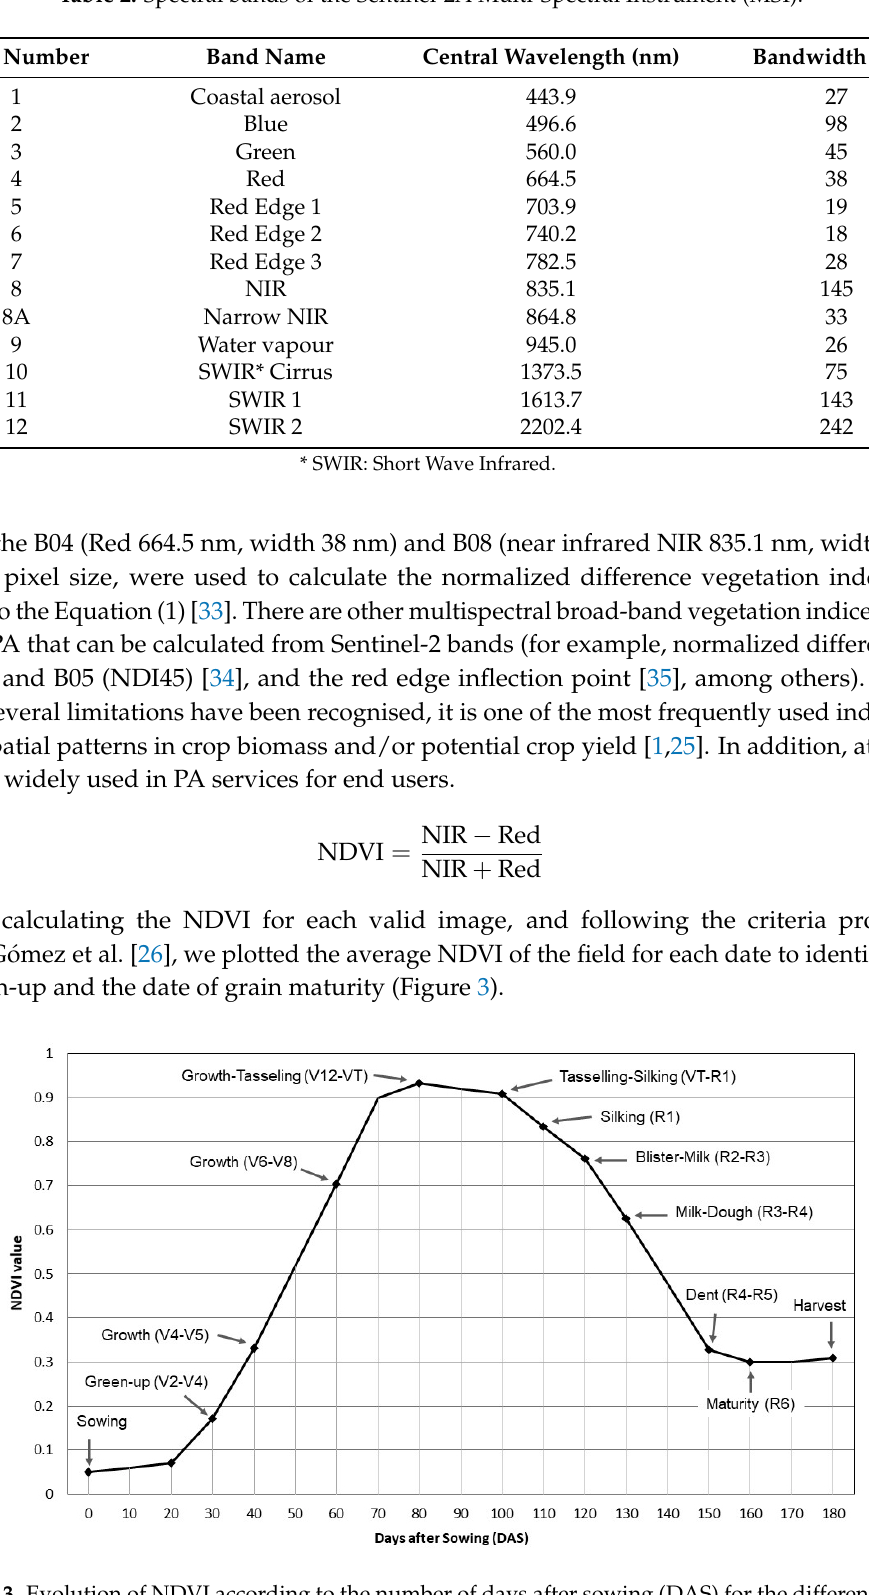
Table 2. Spectral bands of the Sentinel-2A Multi-Spectral Instrument (MSI).